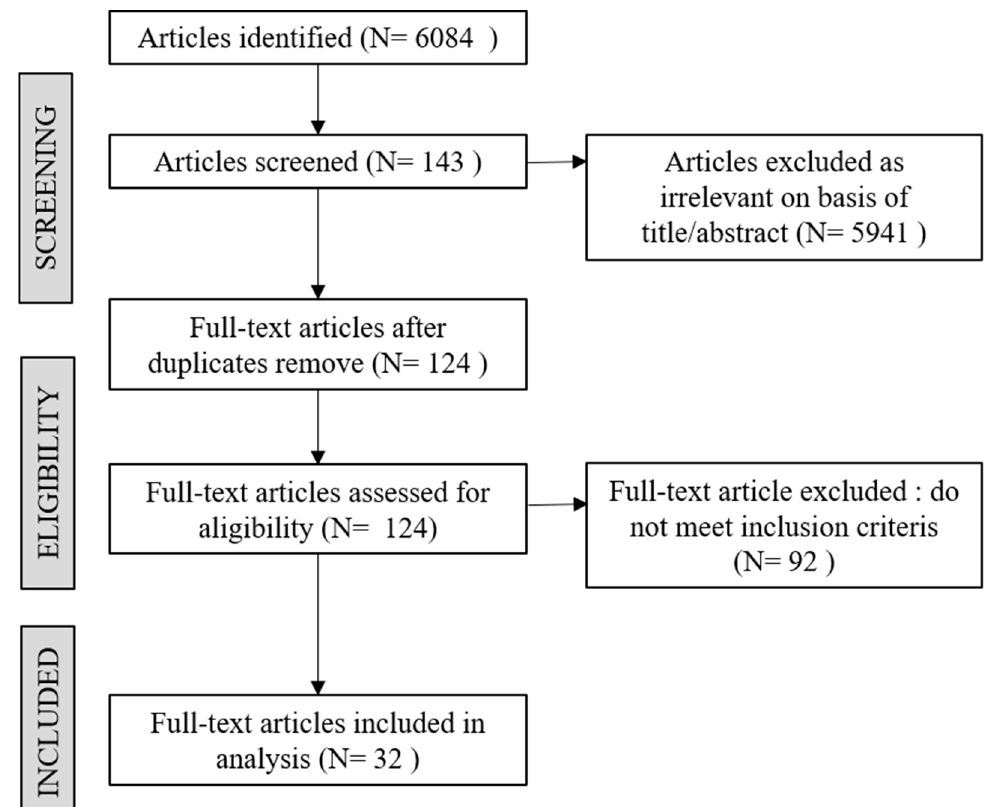
Figure 1. PRISMA process flow.